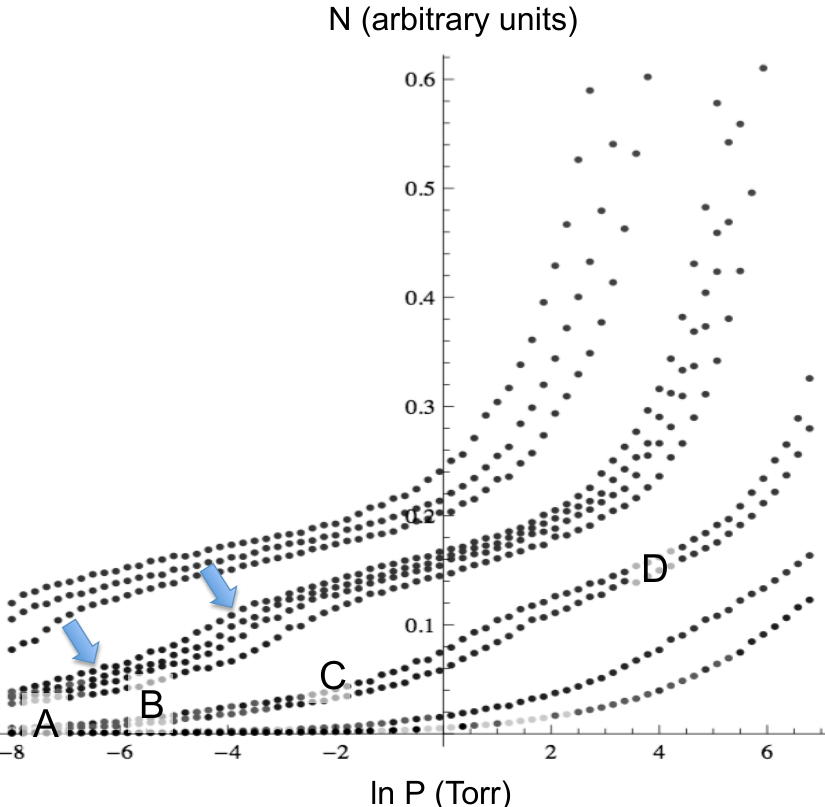
Figure 2. Adsorption isotherms for Ne at temperatures between 18.7 K and 49.8 K. The arrows indicate the bumps, and the labels A to D correspond to the configurations shown in Figure 3.